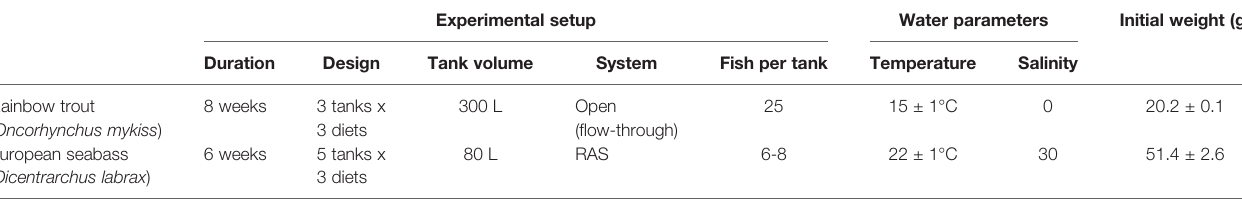
TABLE 2 | Experimental setup and water parameters for the growth trials performed with rainbow trout ( O. mykiss ) and European seabass ( D. labrax ) fed with different levels of glycerol (0, 2.5, and